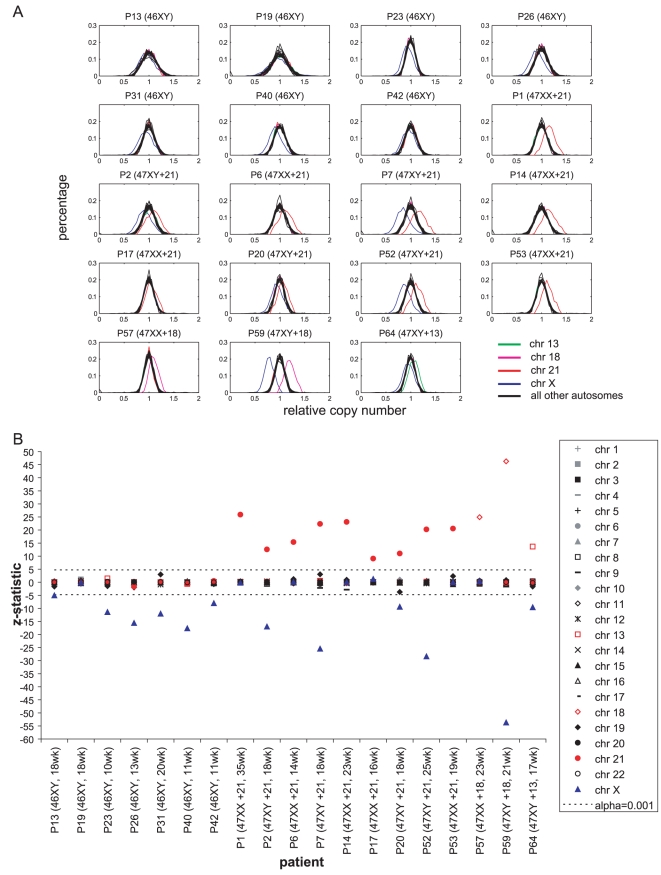
Comparing the distribution of sequence tag density of each chromosome among 19 patients after correcting for GC bias.(A) Distributions of normalized sequence tag density for each chromosome (excluding chromosome Y) within each patient sample. Red: chromosome 21; blue: chromosome X; magenta: chromosome 18; green: chromosome 13; black: all other autosomes. For all but one (P19) male pregnancy sample, it is obvious that the distribution of chromosome X shifts towards the left, while the distributions of chromosomes 21, 18, and 13 for the respective cases of trisomy 21, 18, and 13 shift towards the right, relative to the distributions of all other chromosomes that are present in two copies. (B) The sequence tag distribution of each chromosome is compared to all other chromosomes (except chromosome Y) by calculating the z-statistic. If we require that the copy number of a chromosome to be significantly different from that of all other chromosomes at level α<0.001 to be flagged as abnormal, chromosome X is under-represented as compared to a normal female genome in all but one male pregnancy (P19), while chromosomes 21, 18, and 13 are over-represented in the respective cases of trisomy 21, 18, and 13. Plotted here is the minimum z-statistic for each chromosome when it is compared against 22 other chromosomes. The horizontal dashed line corresponds to the statistic associated with α<0.001.